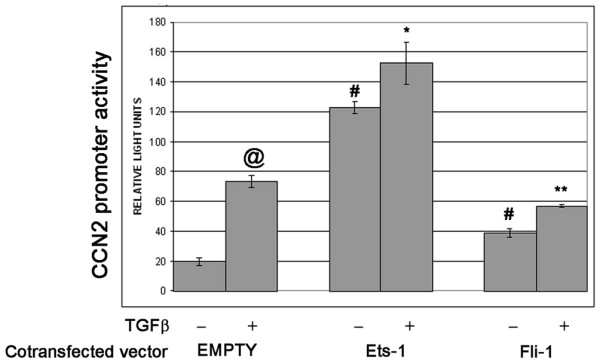
Ets-1, but not Fli-1, enhances the ability of transforming growth factor (TGF)β to induce the CCN2 promoter. A CCN2 promoter/reporter construct driven by nucleotides -805 to +17 of the CCN2 promoter was transfected into fibroblasts in the presence or absence of a 24 h treatment with 4 ng/ml TGFβ1, as indicated. Reporters were co-transfected with empty expression vector, or expression vectors encoding Ets-1 or Fli-1 (0.5 μg expression vector/well) as indicated. Average ± standard deviation (N = 6) is shown. Relative promoter expression is shown. Whereas addition of Ets-1 potentiates the TGFβ1 induction of CCN2 promoter activity (*p < 0.05), Fli-1 limits the TGFβ induction of CCN2 promoter activity relative to the induction of CCN2 promoter activity with TGFβ in the presence of co-transfected empty expression vector (**p < 0.05). Both Fli-1 and Ets-1, however, activate the CCN2 promoter in the absence of TGFβ1 (#p < 0.05). TGFβ induces the CCN2 promoter in the absence of overexpressed transcription factor (@p < 0.05) Average ± standard deviation (N = 6) of a representavtive experiment is shown. Reporter activity was adjusted for differences in transfection efficiencies among samples using a control β-galactosidase expression vector.